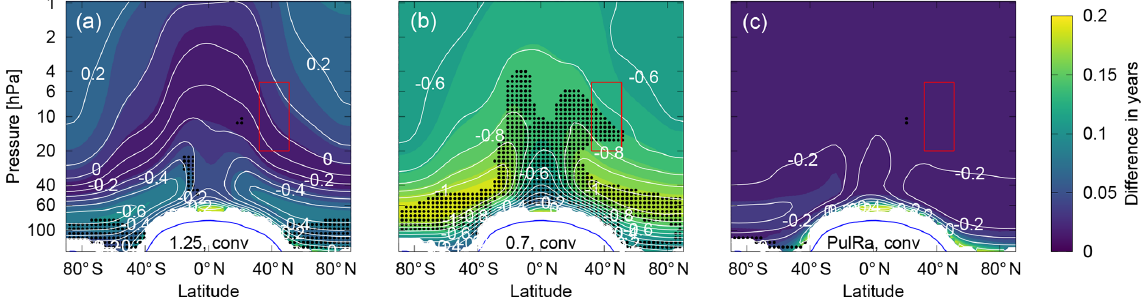
Figure 16. As Fig. 8, in colour are the mean absolute deviations of mean AoA calculated from SF 6 from AoA derived from an ideal tracer for every month from 1975 to 2011 for different ratios of moments using the convolution method. (a) is 1.25 years of a ratio of moments and (b) is 0.7 years. PulRa denotes the ratio of moments derived from the tranPul simulation annual mean extended age spectra (c) . The white contours are the difference in trends in 10 − 1 years per decade. White areas indicate where the derivation is not applicable. Black stippling shows the insignificance of the SF 6 trend from zero on the 95% confidence level. The trend calculation considered the time series from 1975 to 2011. The red box shows the range of the balloon